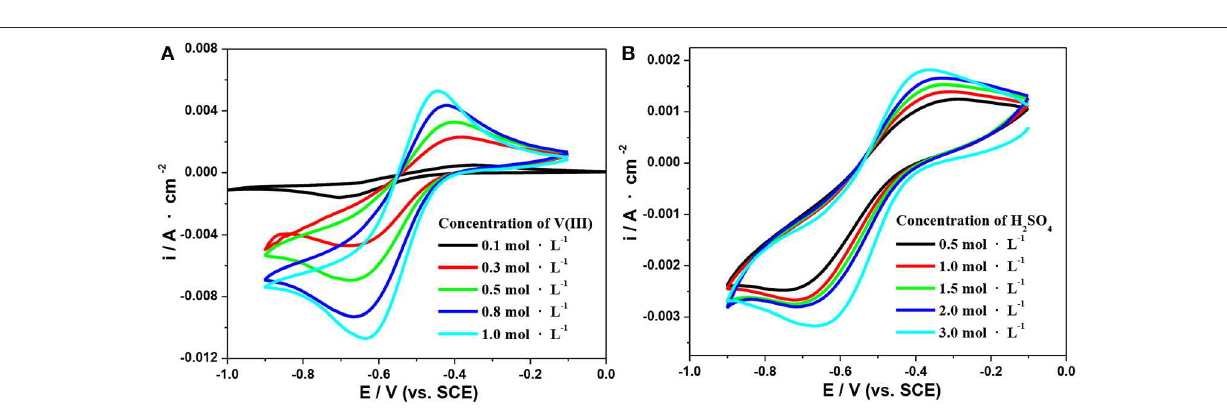
Frontiers in Chemistry | www.frontiersin.org